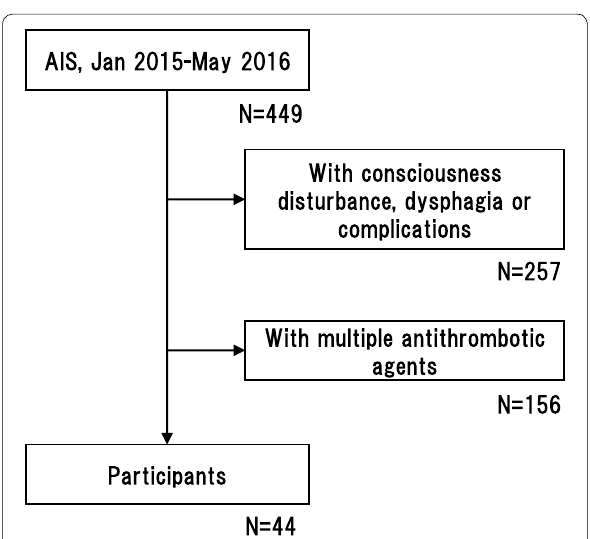
Fig. 1 The inclusion and exclusion criteria with number of patients